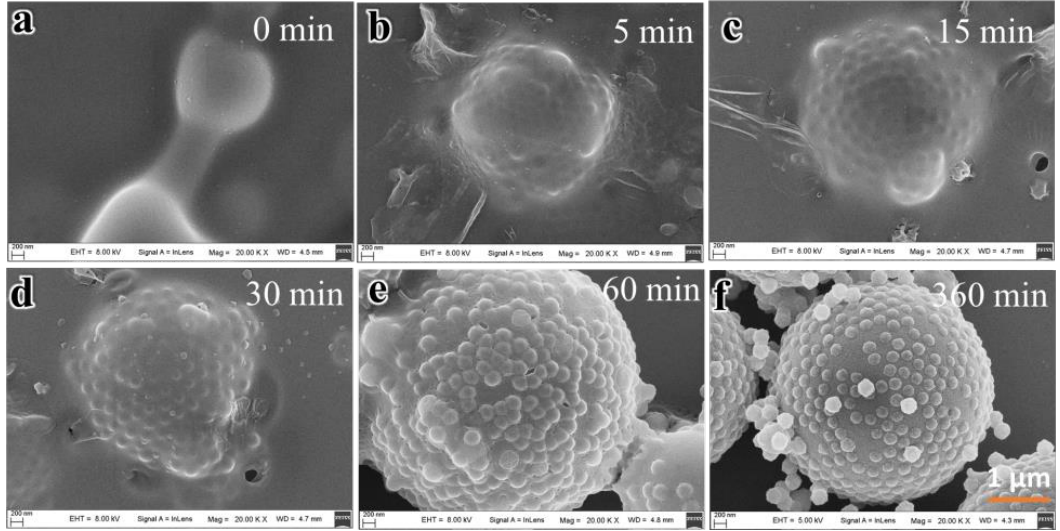
Figure 3. SEM images of the HSOS particles formed at different reaction times: ( a ) 0 min, ( b ) 5 min, ( c ) 15 min ( d ) 30 min, ( e ) 60 min, ( f ) 360 min.